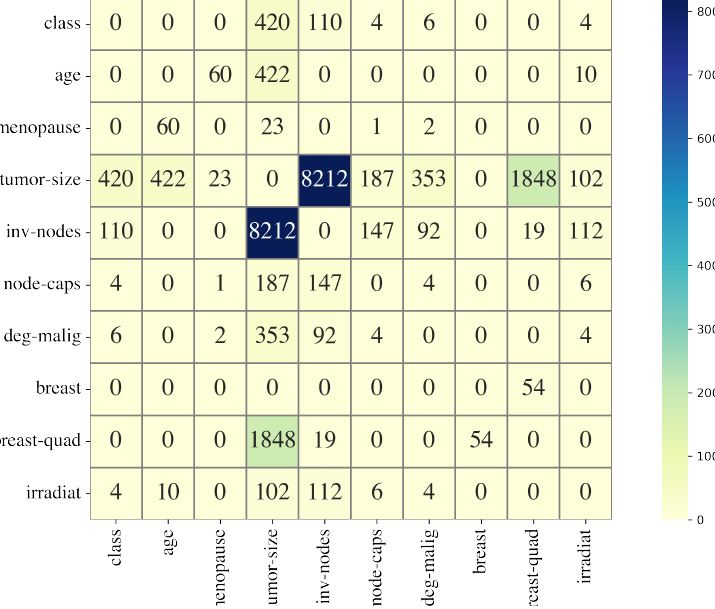
Figure 5. Associations detected in the Breast Cancer data